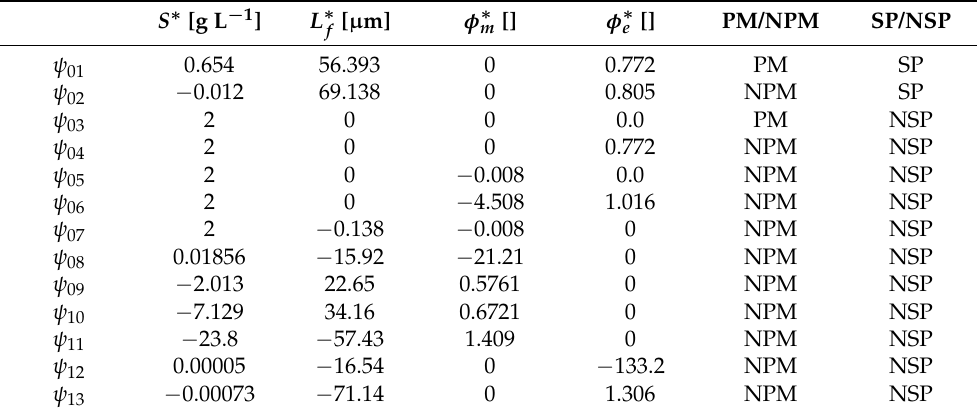
Table 4. Table 6. Equilibrium points ψ of reduced model in (21).